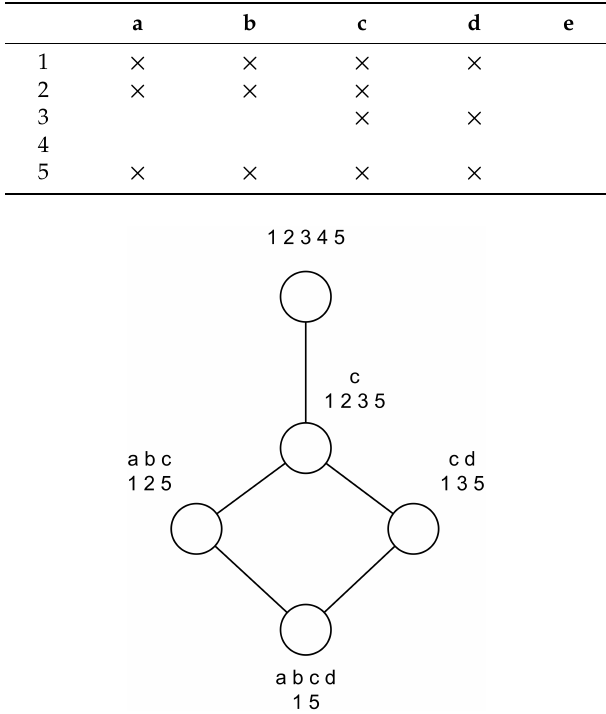
Table 1. Example of the formal context before adding the attribute e .